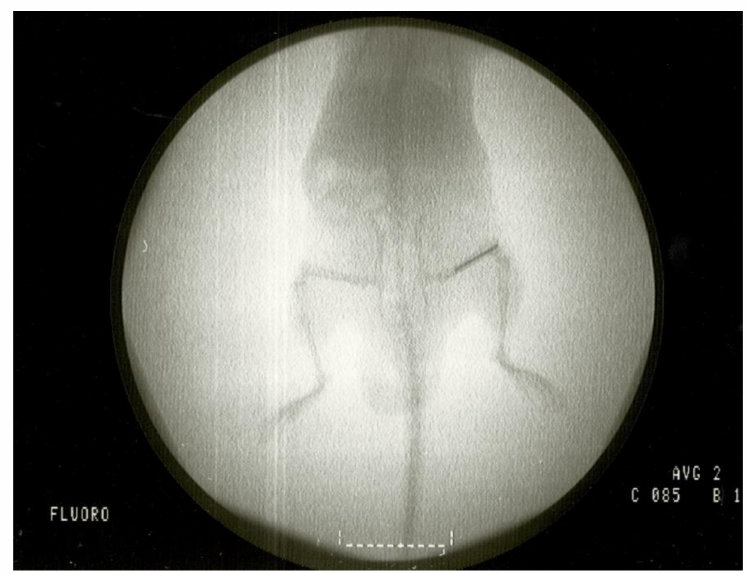
Figure 10. Fluoroscopy of a mouse with an implant placed in the